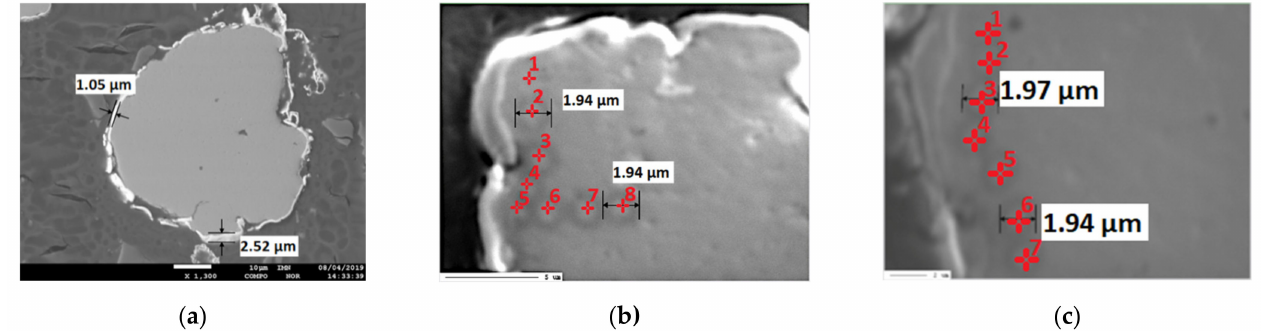
Figure 6. ( a ) SEM picture of NiCr + 30Re powder; ( b ) and ( c ) SEM pictures of NiCr + 30Re powder particles with marked analysis points and “burned” traces indicating excitation areas. Table 5. Elemental composition of NiCr + 30Re powders investigated by the WDS method in areas shown in Figure 6. Area 1 (Figure 6b), wt.% Area 2 (Figure 6c), wt.% Area No.